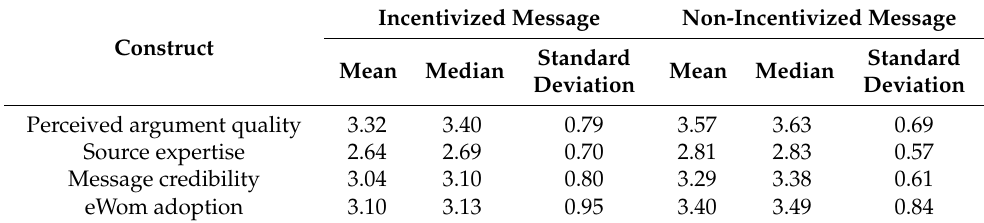
Table 3. Means, medians and standard deviations of latent constructs.